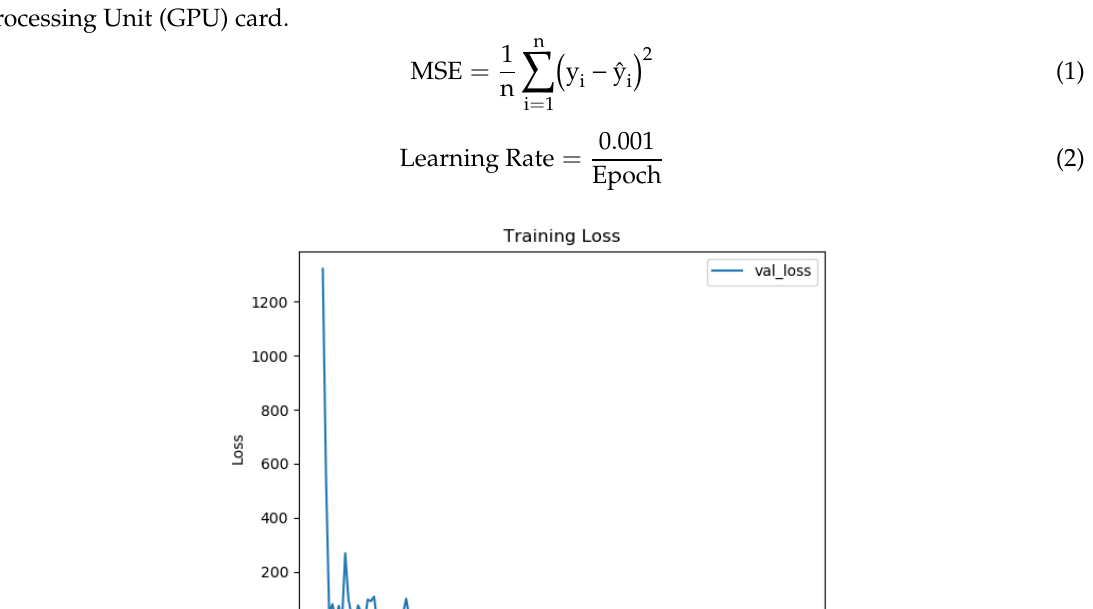
Figure 13. Training results of 150 epochs.